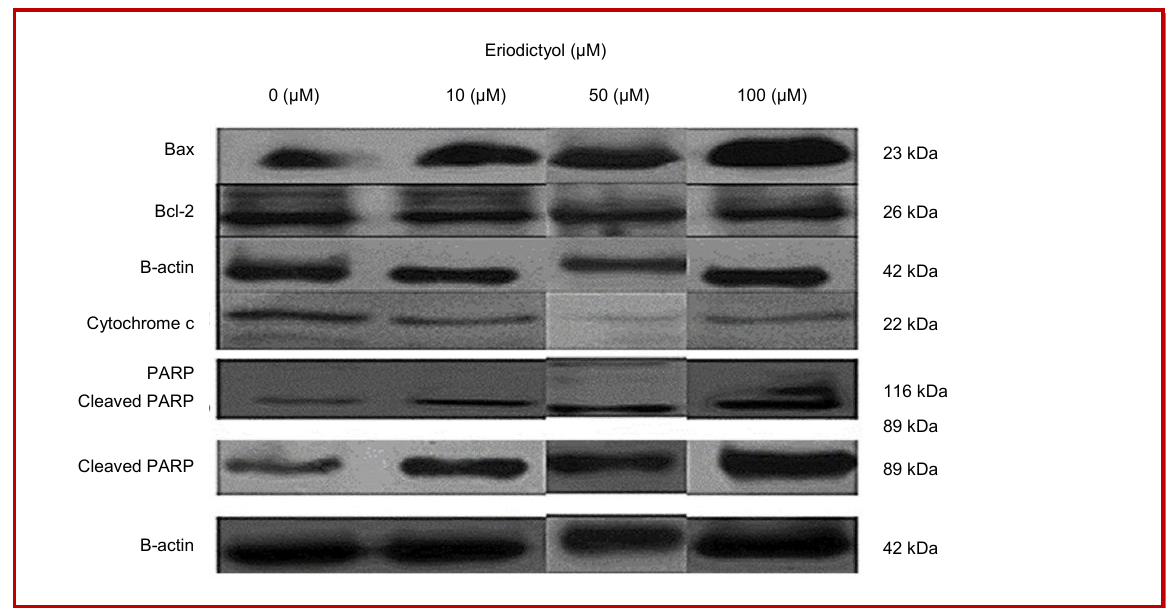
Figure 6: Graphical representation of the increase in the G2/M phase cells (G2/M arrest) after the Hep-G2 cells were treated with 0, 10, 50 and 100 µM eriodictyol for 48 hours. The results are mean ± SEM and mean values of three independent experi- ments. a p<0.05, b p<0.01 versus the 0 μ M (untreated control)